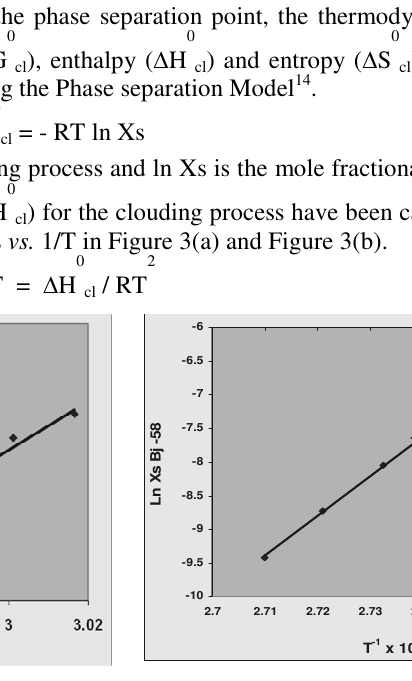
Figure 3 (b). CP of Brij 58 at different